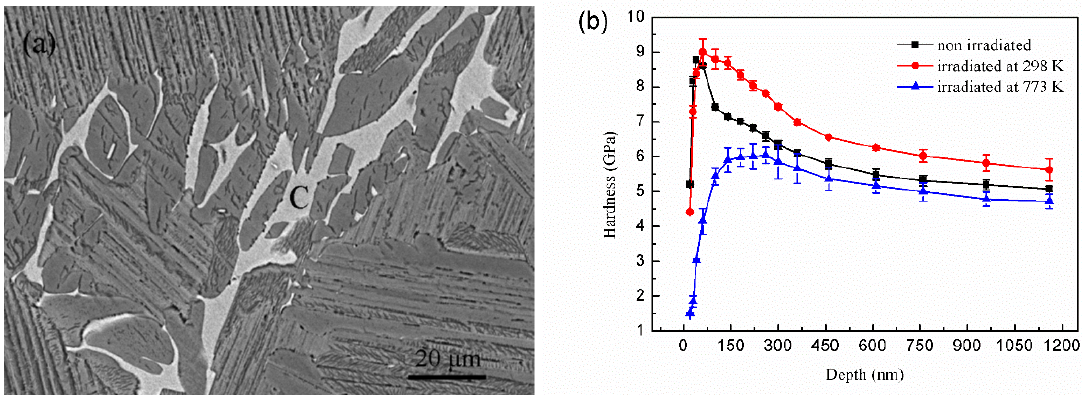
Figure 9. Nanoindentation hardness of the experimental high Nb-containing TiAl alloy. ( a ) The position of nanoindentation tests in the alloy: C β phase. ( b ) The curve of nanohardness with depth in β phase before and after ion implantation of as-cast alloy.